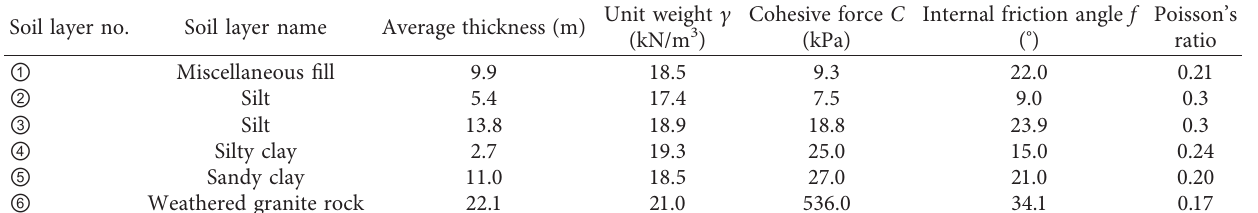
Table 1: Soil parameters.